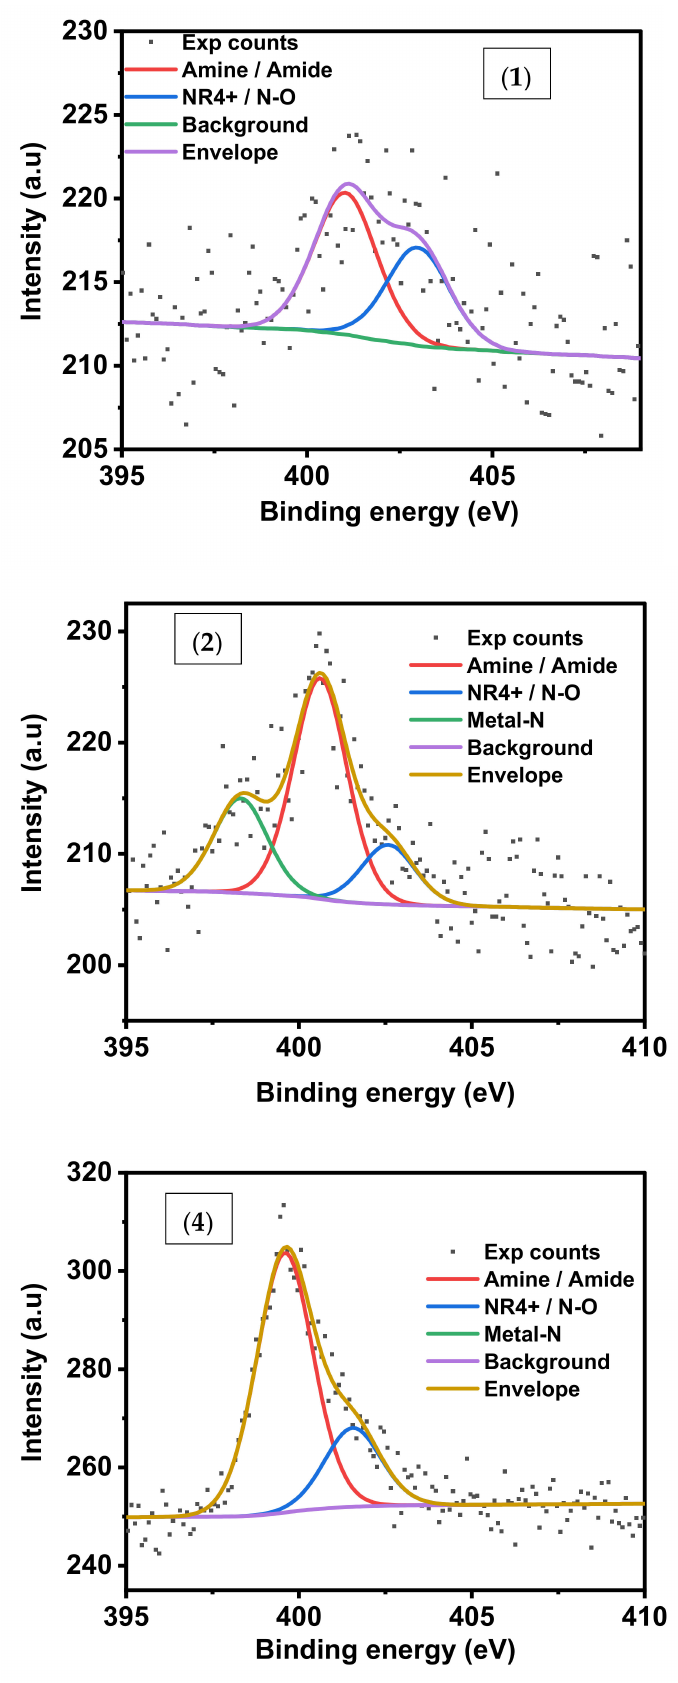
Figure 7. XPS convolution N1s spectrum for the three samples (1), (2) and